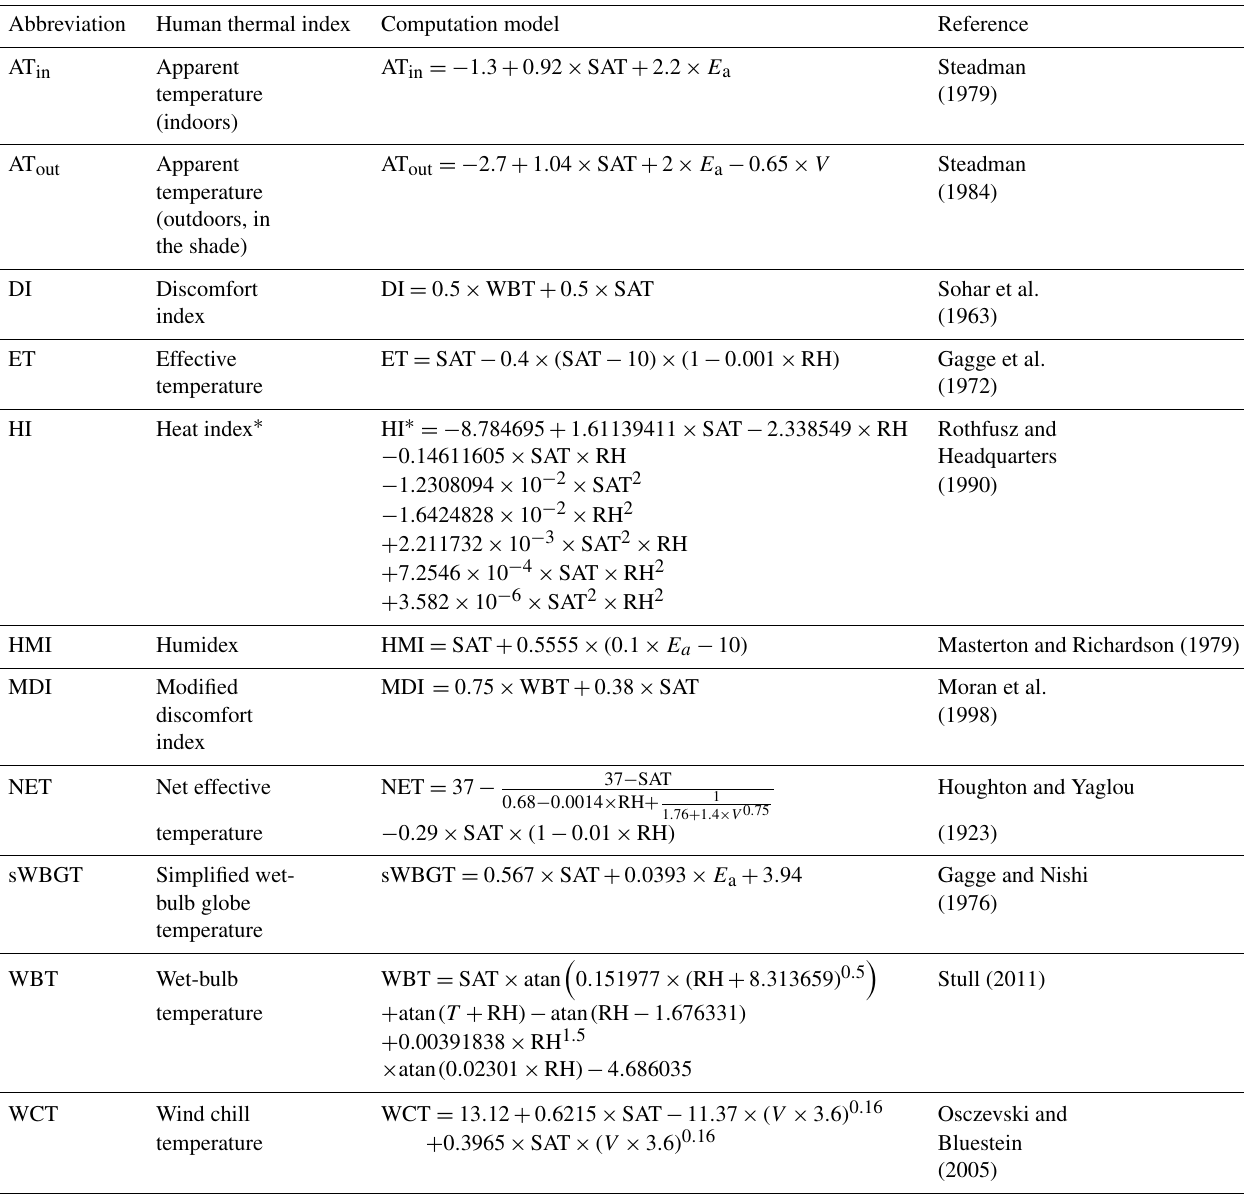
Table 2. Equations of the human thermal indices for each